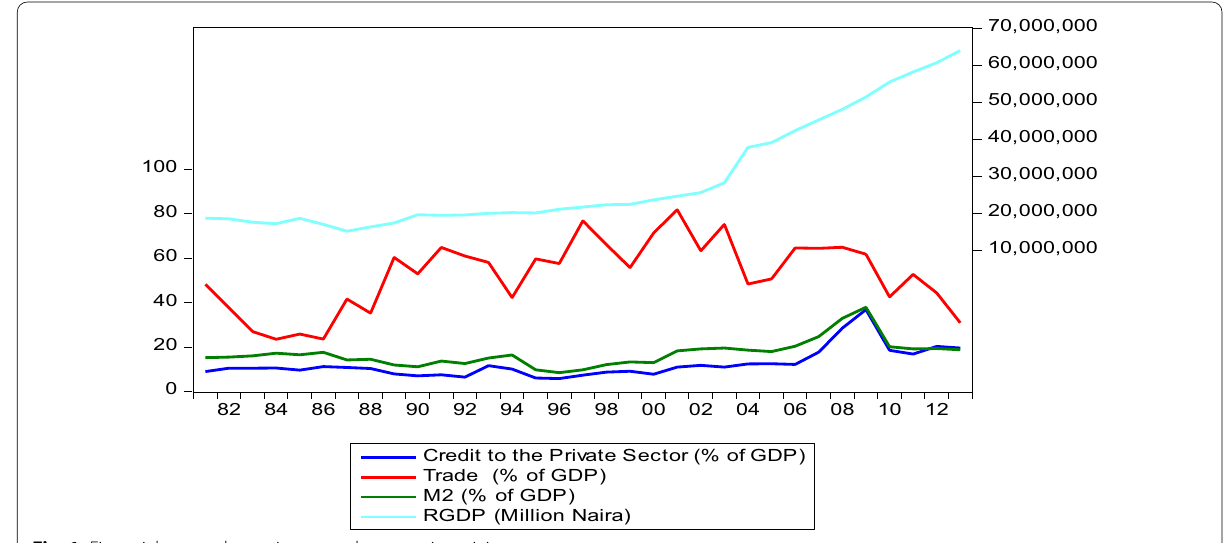
Fig. 1 Financial sector determinants and economic